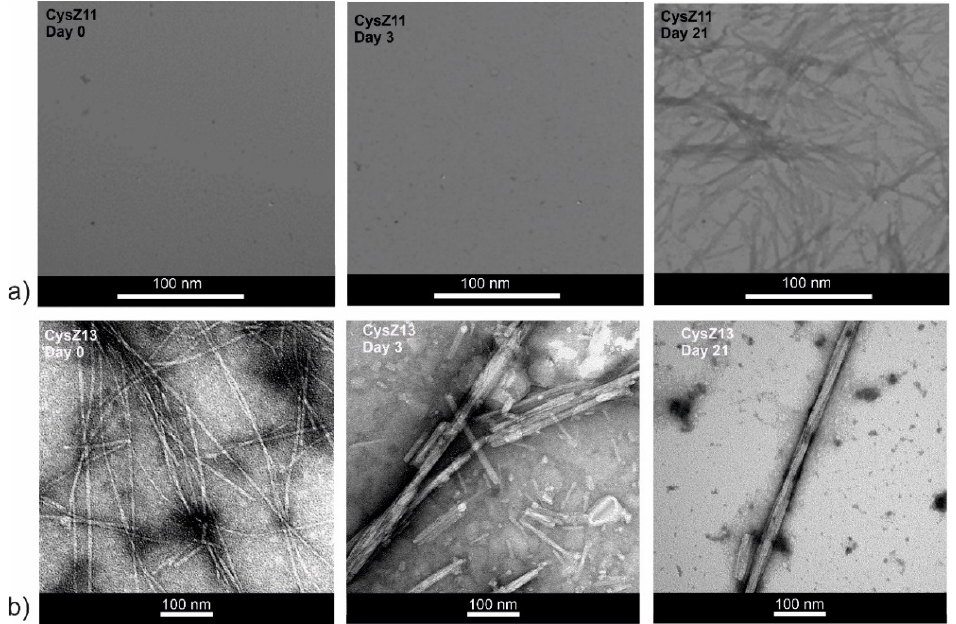
Figure 5. Transmission electron micrographs (TEM) for peptides ( a ) CysZ11 and ( b ) CysZ13, taken before, on the 3rd day, and after 21 days of incubation in PBS buffer pH 4.0.